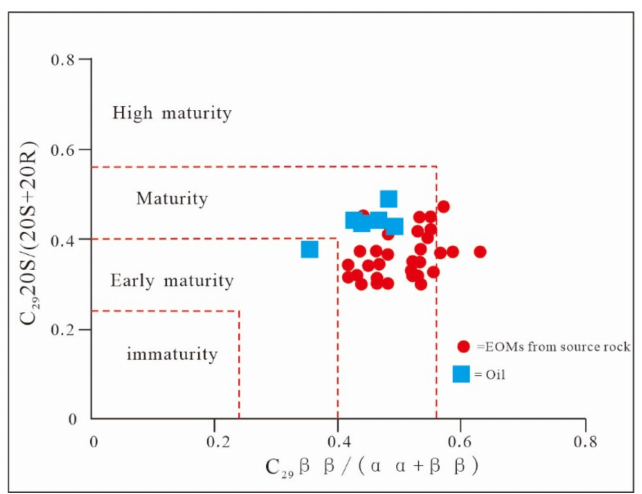
Figure 13. A cross plot of C29 sterane 20S/(20S + 20R) and C29 Sterane ββ /( αα + ββ ), adapted from